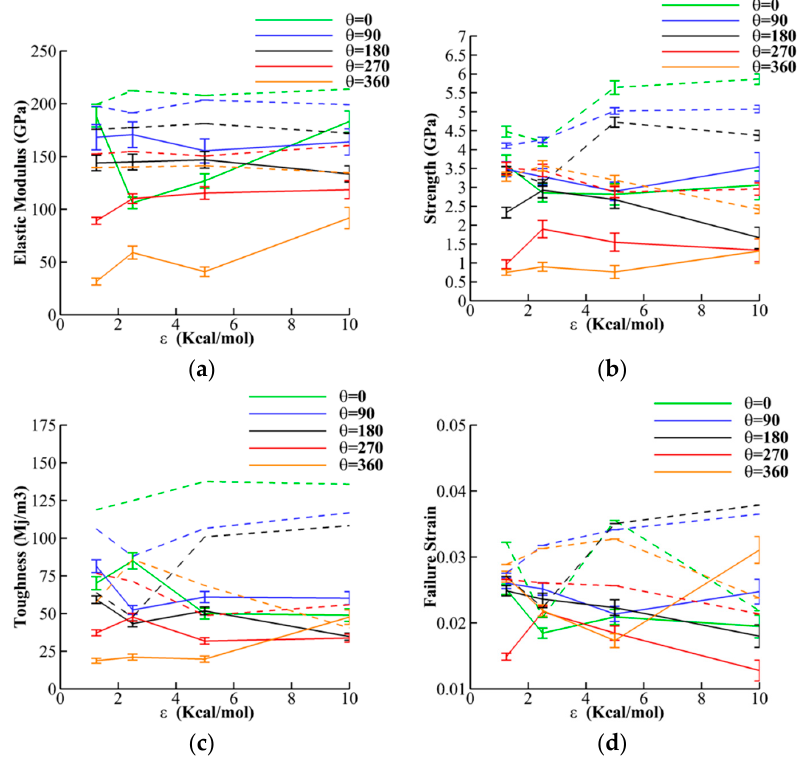
Figure 4. Mechanical performance of 5 × 5 (solid lines) and 2 × 2 (dashed lines) twisted bundle of CNCs for different interfacial interactions. ( a ) elastic modulus, ( b ) strength, ( c ) toughness, and ( d ) failure strain.